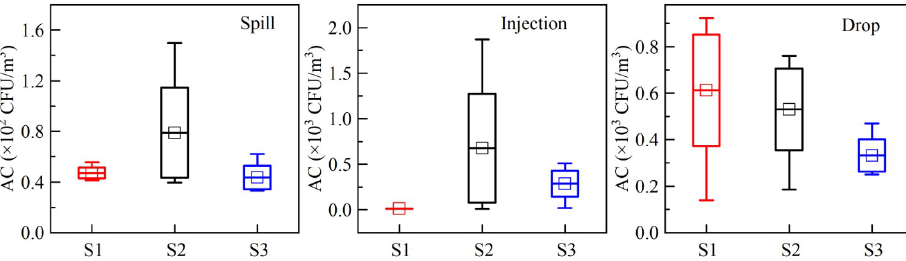
Figure 4. Culturable bioaerosol concentration at each sampling point. AC is aerosol